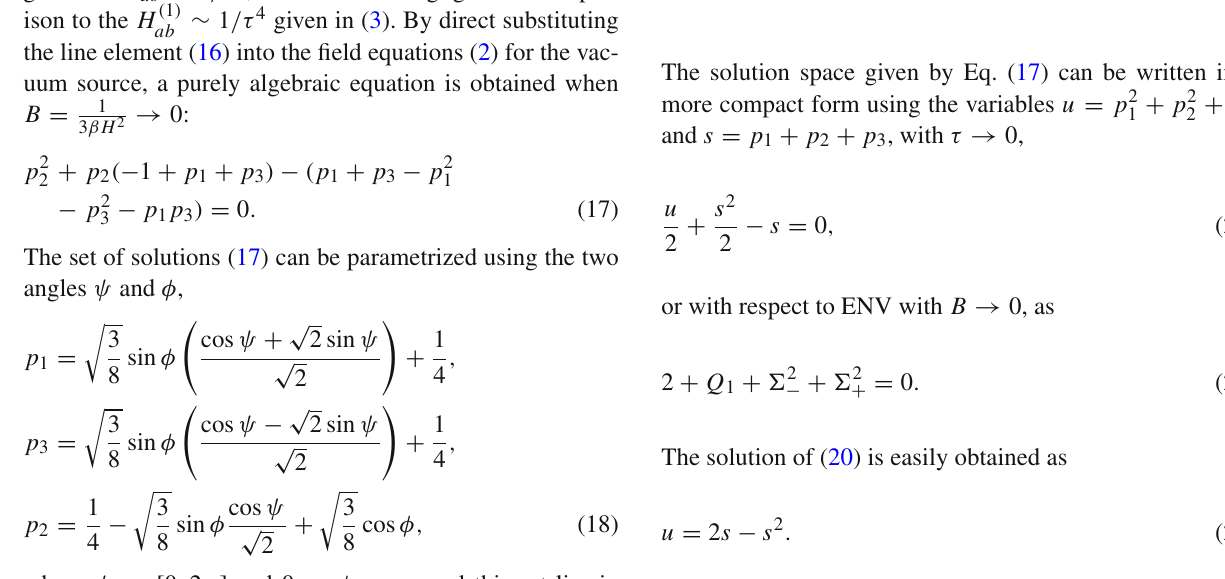
The solution space given by Eq. (17) can be written in a more compact form using the variables u = p 2